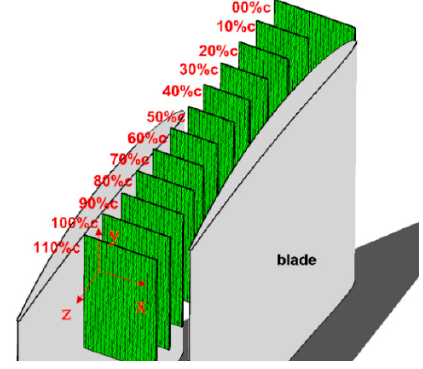
Figure 4. Layout of SPIV measurement cross-sections.